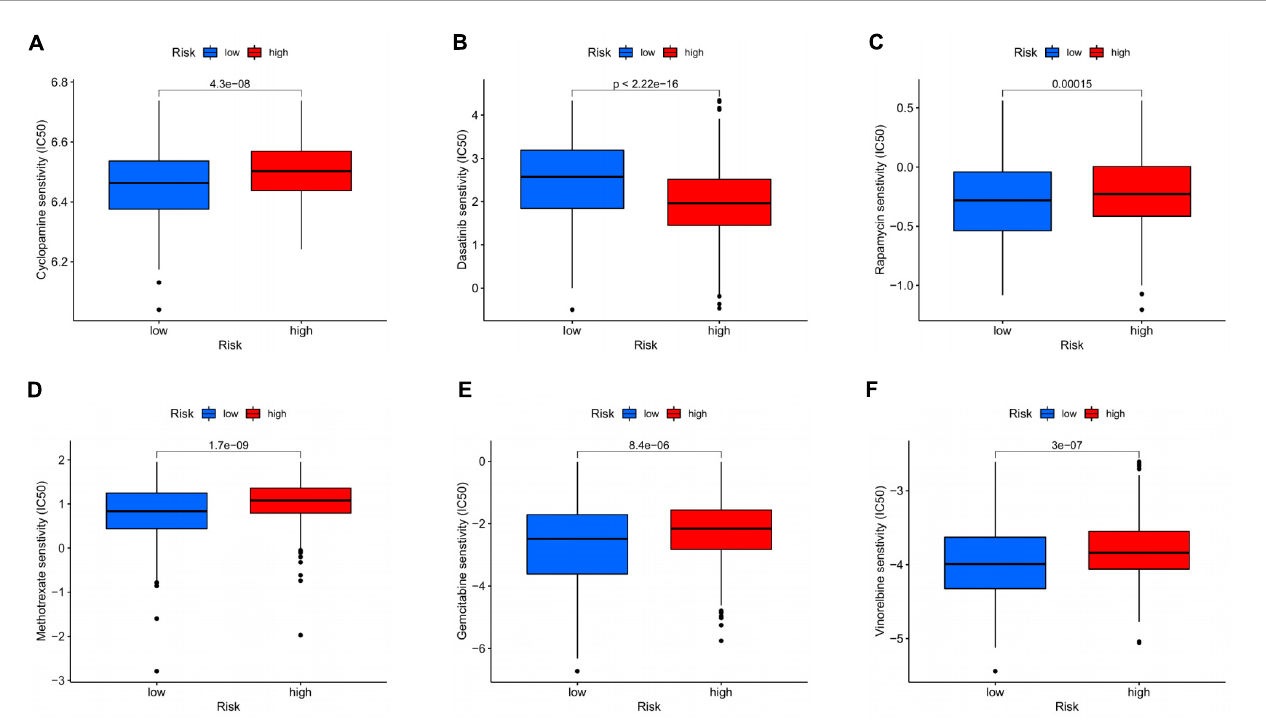
FIGURE10 Drug sensitivity analysis based on CDEGs-score. (A–F) Relationship between chemotherapeutic drugs and CDEGs-Score. CDEGs, cancer associated fibroblast related differential expression